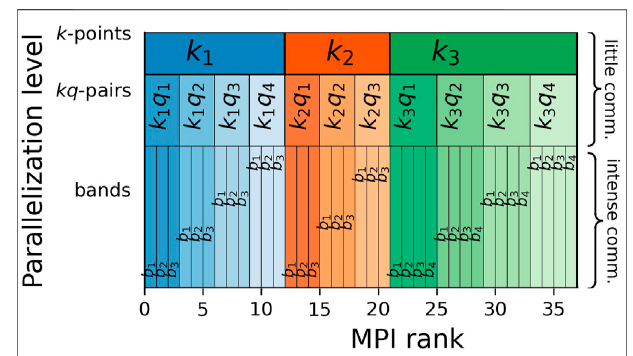
FIGURE 2 | The distributed-memory parallelization of Eq. 2 is divided into three levels. For each k -point the exact exchange is calculated as an independent problem. At a k -point k i , the exact exchange is calculated as a sumoverall q -pointsassociatedwith k i ,buildingthe kq -pairs.These fi rst two levels require very little communication, i.e., copying the fi nal results to theirdestinationforthe k -pointsandareductionwithinthesub-communicator of each k -point for the q -point sum. The third level of distributed-memory parallelizationcalculatesgroupsofoccupiedbands n ′′ inparallel.Here,alotof inter-dependencies create a much larger communication demand compared to the fi rst two levels. In a typical calculation of the non-local potential the workloadisnotuniformlydistributed:Some k -points havemore q -pointsthan others and some kq -pairs might have more associated bands than others. The algorithm attempts to compensate this by assigning more nodes to heavier